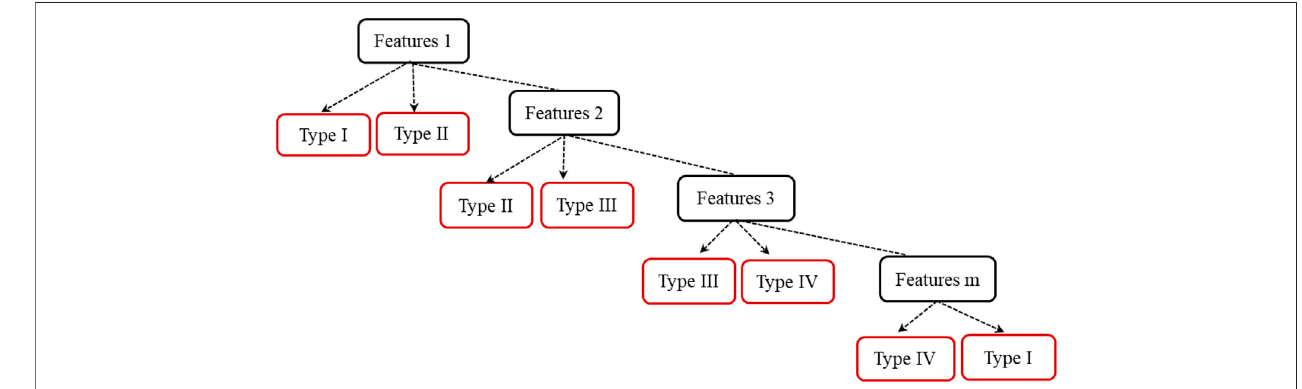
FIGURE 2 | The tree structure of the decision tree.